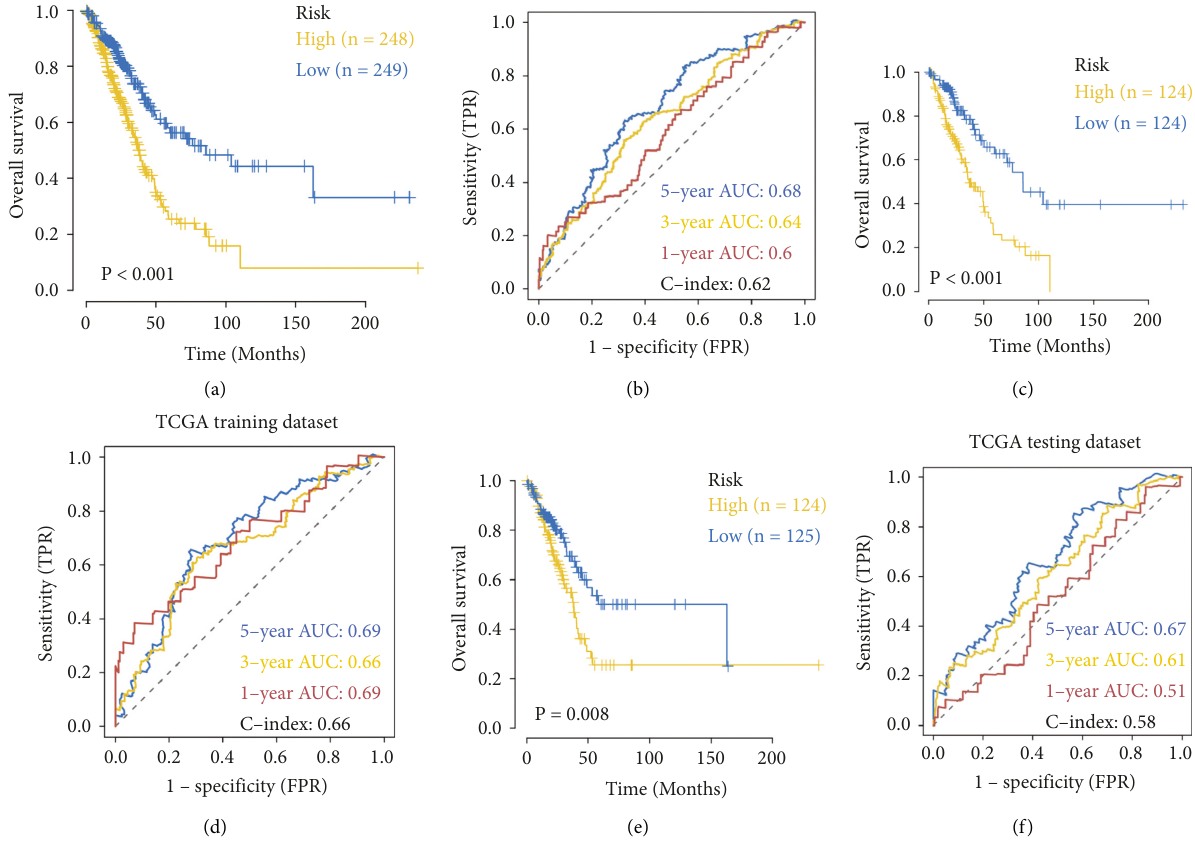
Figure 6: Overall survival analysis of six miRNA in training and validation sets. (a) KM analysis of the TCGA samples’ OS using the risk score derived from the prognostic model. ROC evaluated the prognostic effect of the model; (c–d) the analysis in the training set; (e–f) the analysis in the validation